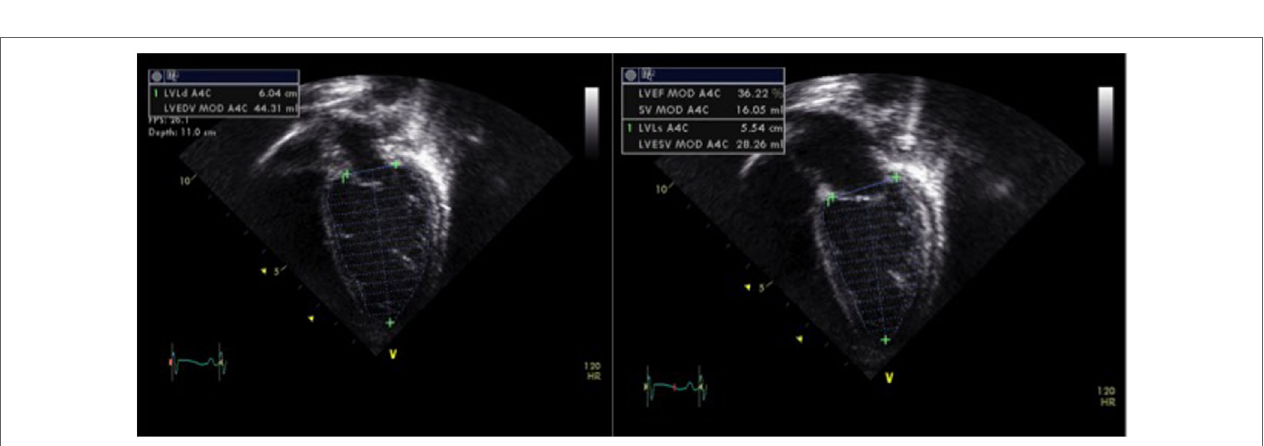
FigURe 2 | M-mode echocardiography obtained from a patient (left image) with normal left ventricular systolic function (FS = 34% and EF = 65%) and in a patient (right image) with dilated cardiomyopathy with severe left ventricular systolic dysfunction (FS = 8% and EF = 16%), LVEDD with green arrow and LVESD with blue arrow. Abbreviations: EF, ejection fraction; FS, fractional shortening; LVEDD, left ventricle end-diastolic dimension; LVESD, left ventricle end-systolic dimension.